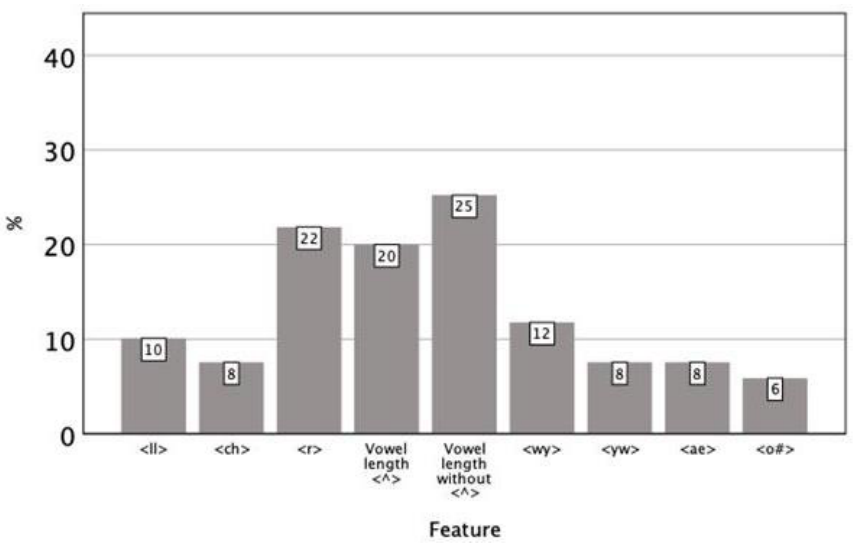
Figure 4. Percentage of speaker responses about individual features of their own pronunciation.